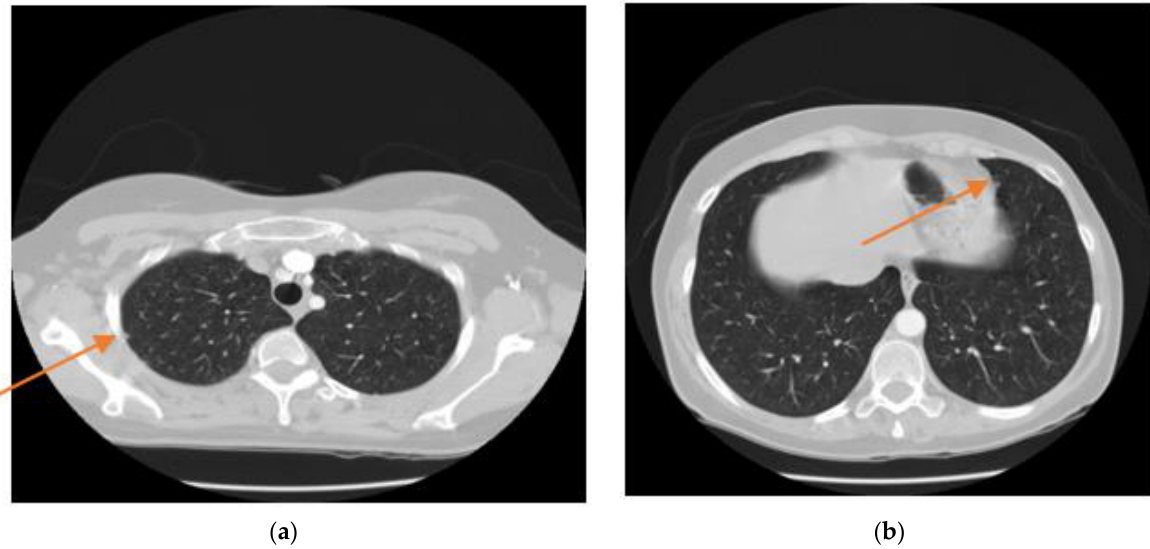
Figure 1. Two examples of nodules attached to the lung wall in CT-scan images. ( a ). represents one nodule attaching to the outer wall of the lung, ( b ). represents one nodule attaching to the outer wall of the lung (orange arrows).